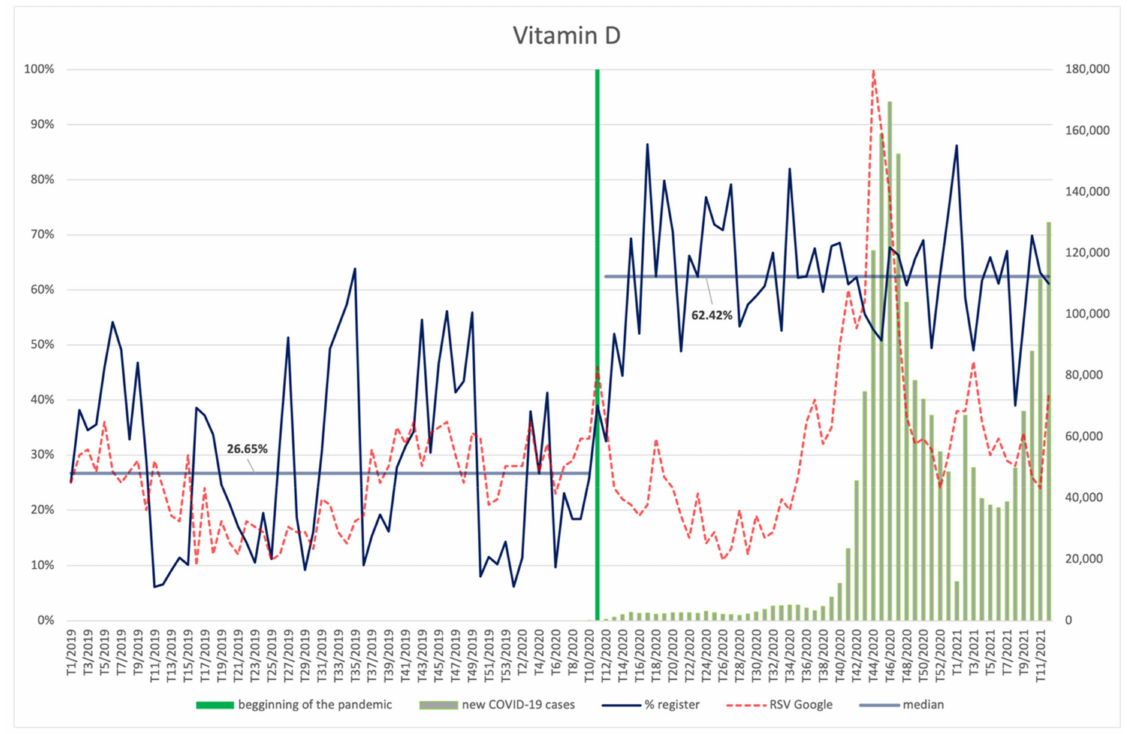
Figure 9. Comparison between the number of new registrations of products containing vitamin D, the number of COVID-19 cases, and the frequency of search for information on the ingredient in the Google